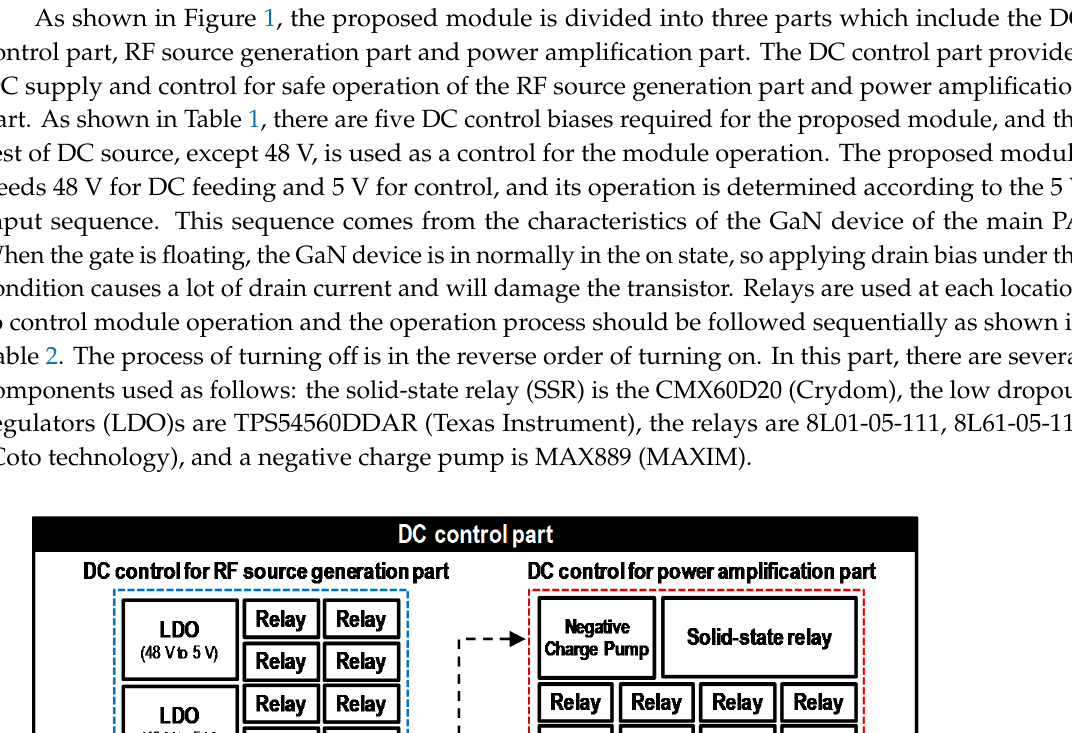
components used as follows: the solid-state relay (SSR) is the CMX60D20 (Crydom), the low dropout regulators (LDO)s are TPS54560DDAR (Texas Instrument), the relays are 8L01-05-111, 8L61-05-111 (Coto technology), and a negative charge pump is MAX889 (MAXIM).